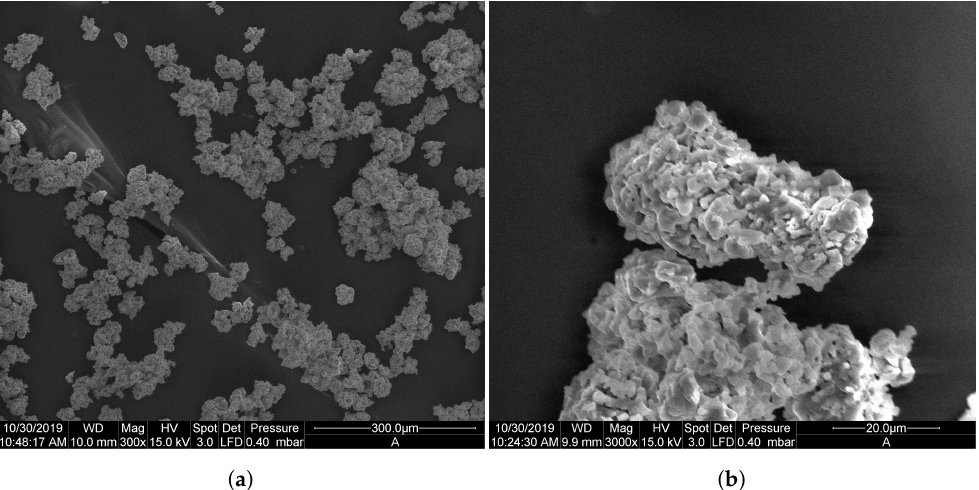
Figure 1. ( a ) SEM image of the uniform particle batch of K 2 CO 3 particles sieved to have a diameter of 25–38 µ m. ( b ) Zoom-in of one